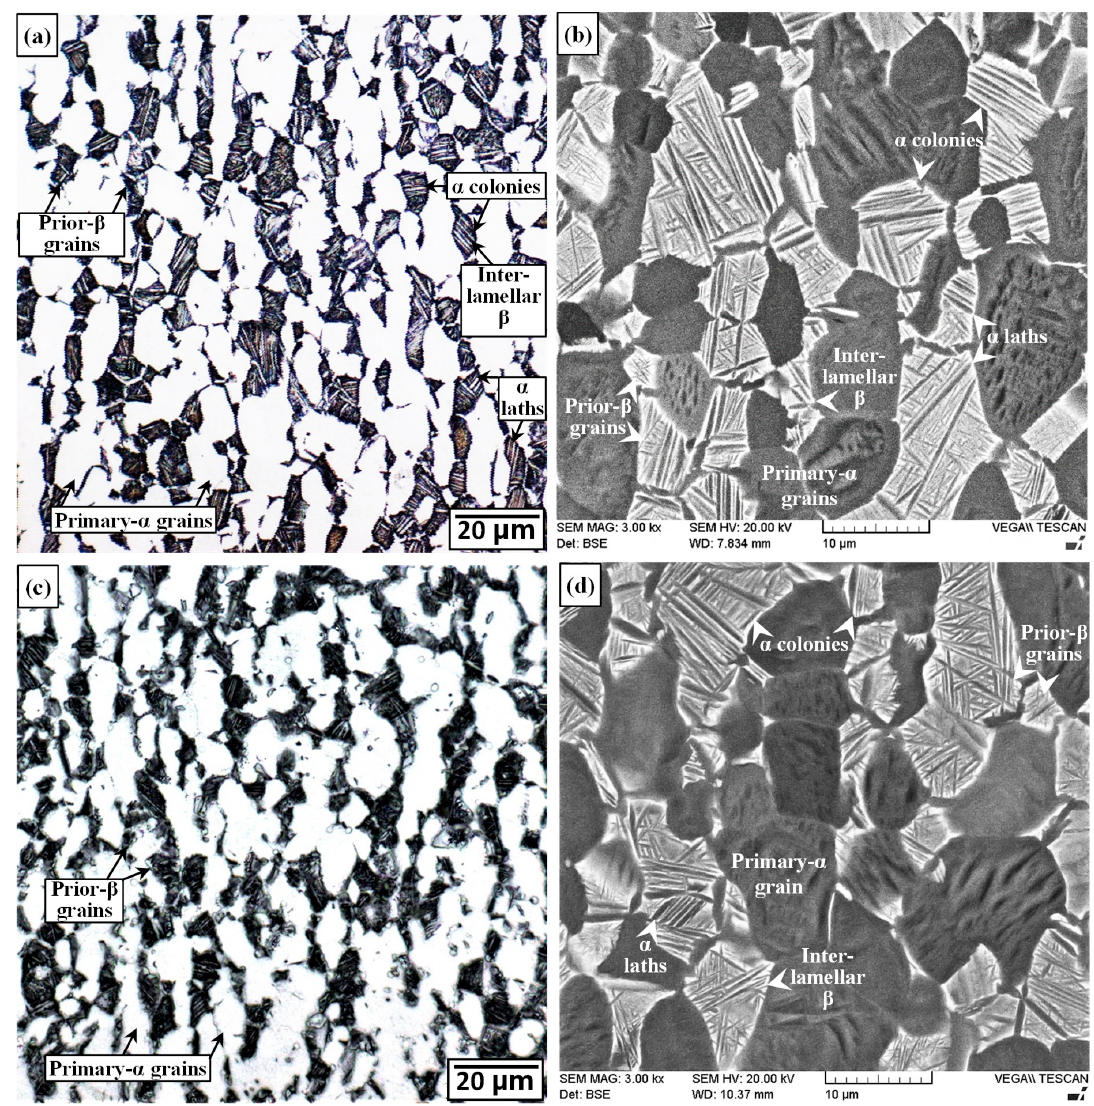
Figure 5. Microstructure of Ti-6242 PM ( a , b ) as-received (OM and SEM) and ( c , d ) SRAed (OM and SEM).